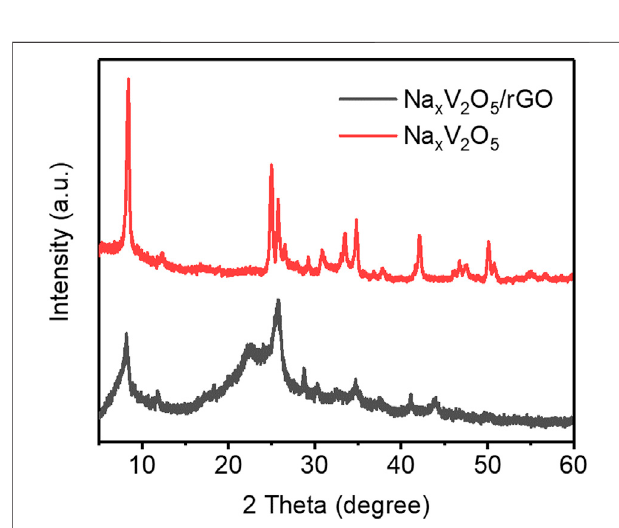
FIGURE 2 | XRD patterns of as-synthesized Na x V 2 O 5 powder and Na x V 2 O 5 /rGO fi